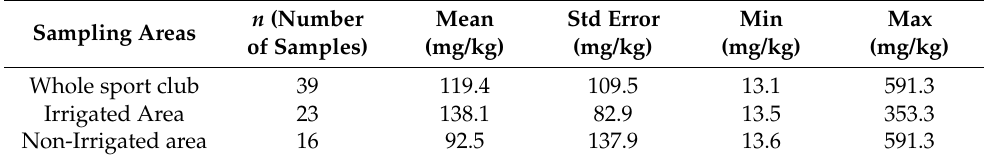
Table 3. Total As concentrations (tAs) in surface soils in irrigated (IA) and non-irrigated areas (NIA). Sampling